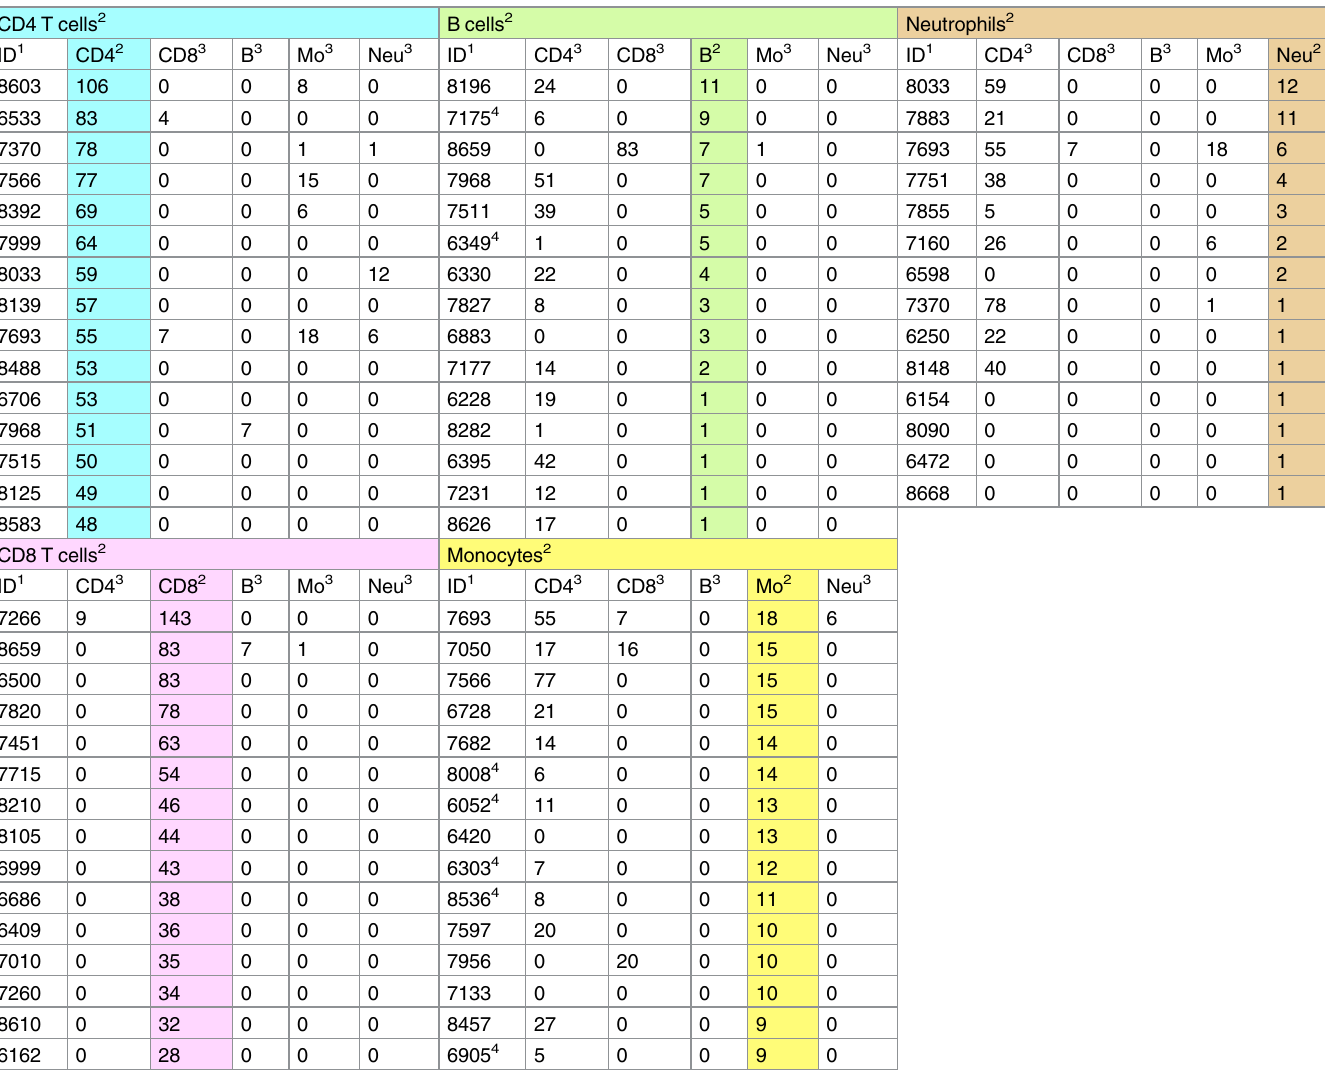
Table 2. Top 15 clones of each cell lineage in